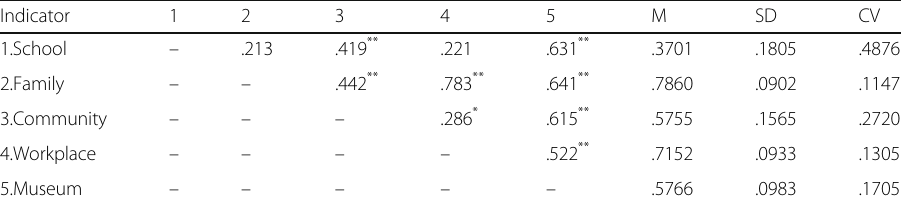
Table 4 Intercorrelations, Means, Standard Deviations, Coefficient of Variation for five learning environment indicators ( N =